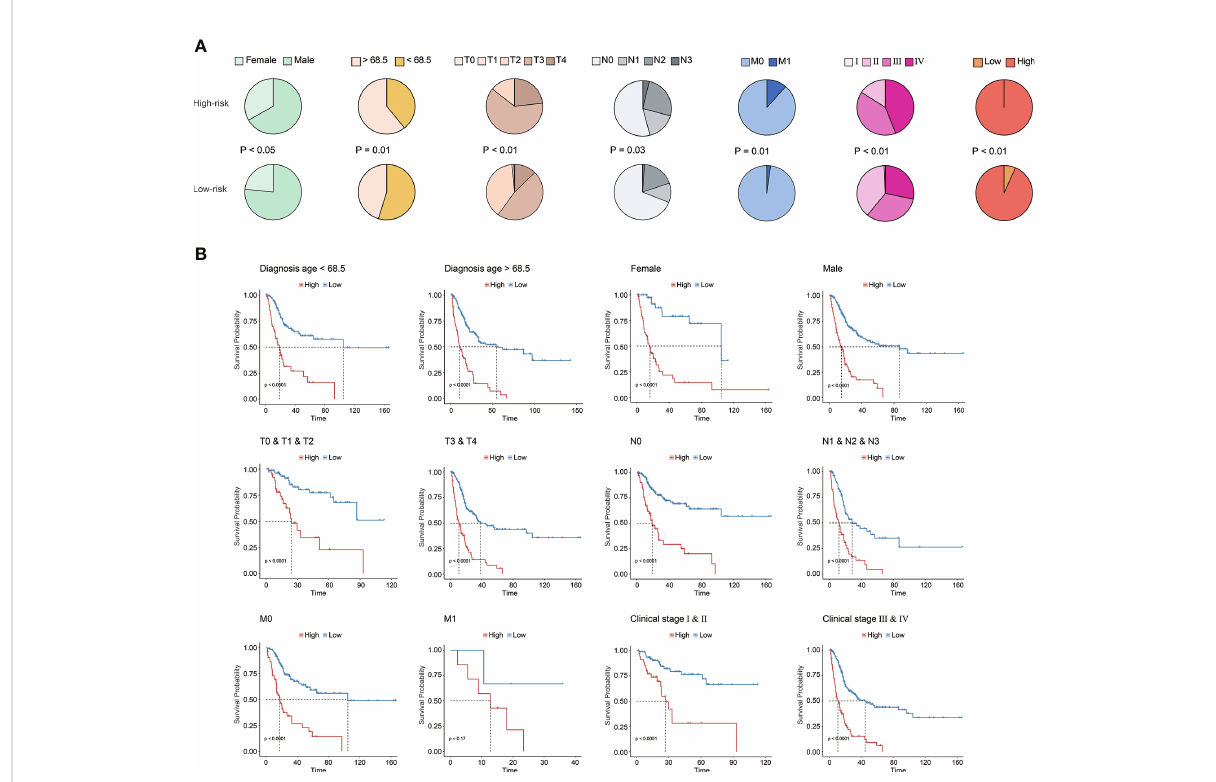
FIGURE 4 Clinical association of the CRG signature. (A) The association analysis between the CRG signature and clinical features in the TCGA-BC cohort. (B) The prognostic CRG signature predicted prognosis for BC patients with different clinical features in the TCGA-BC